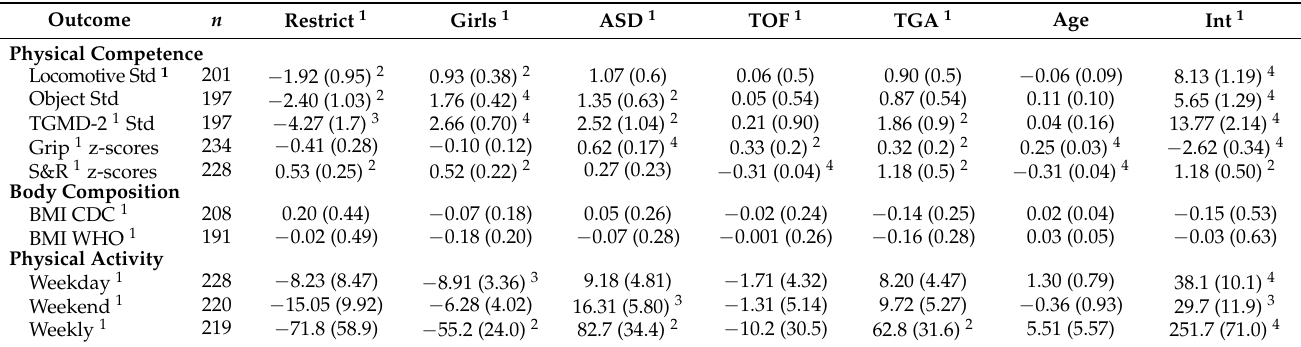
Table 2. Association between health-related fitness and parent-reported restriction of competitive sport among children with CHD, adjusting for sex, age, and type of CHD.